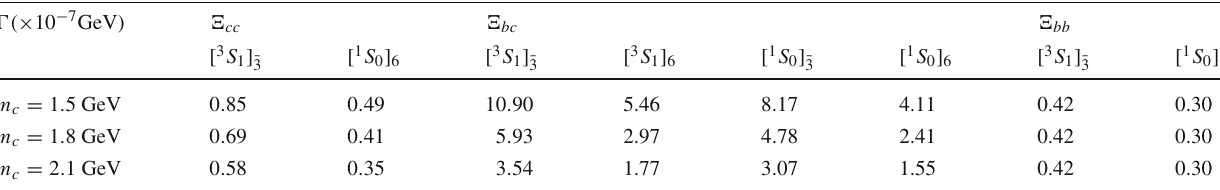
Table 5 The theoretical uncertainties for the production of baryons (cid:2) QQ (cid:3) via Higgs boson decays by varying m c = 1 . 8 ± 0 . 3 GeV (cid:6)( × 10 − 7 GeV)